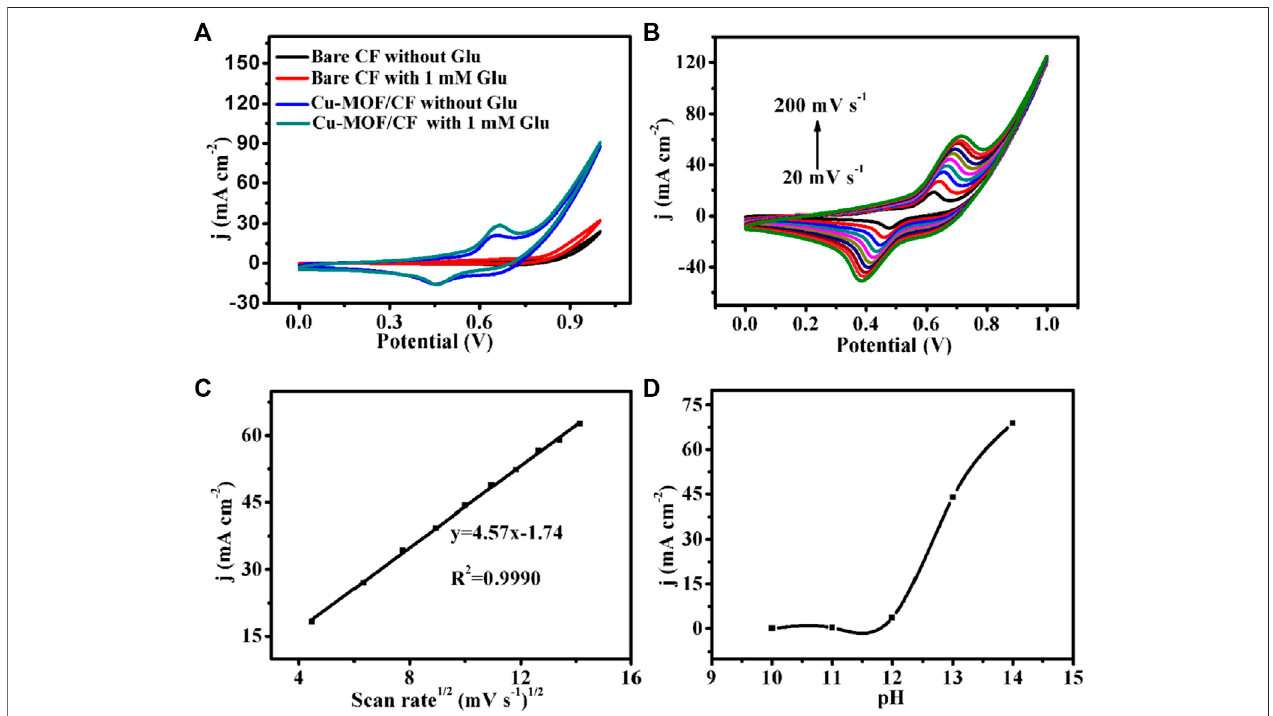
FIGURE3|(A) CVsofbareCFandCu-MOF/CFin0.1MNaOHintheabsenceandpresenceof1mMGlu(scanrate:50mVs − 1 ). (B) CVsforCu-MOF/CF in1mM Glu at scan rates from 20 to 200 mV s − 1 . (C) Corresponding plot of current density vs . the square root of the scan rate. (D) Plot of anodic peak current density vs pH for the Cu-MOF/CF electrode in the presence of 1 mM glucose at 0.65 V (scan rate, 50 mV s − 1 ).